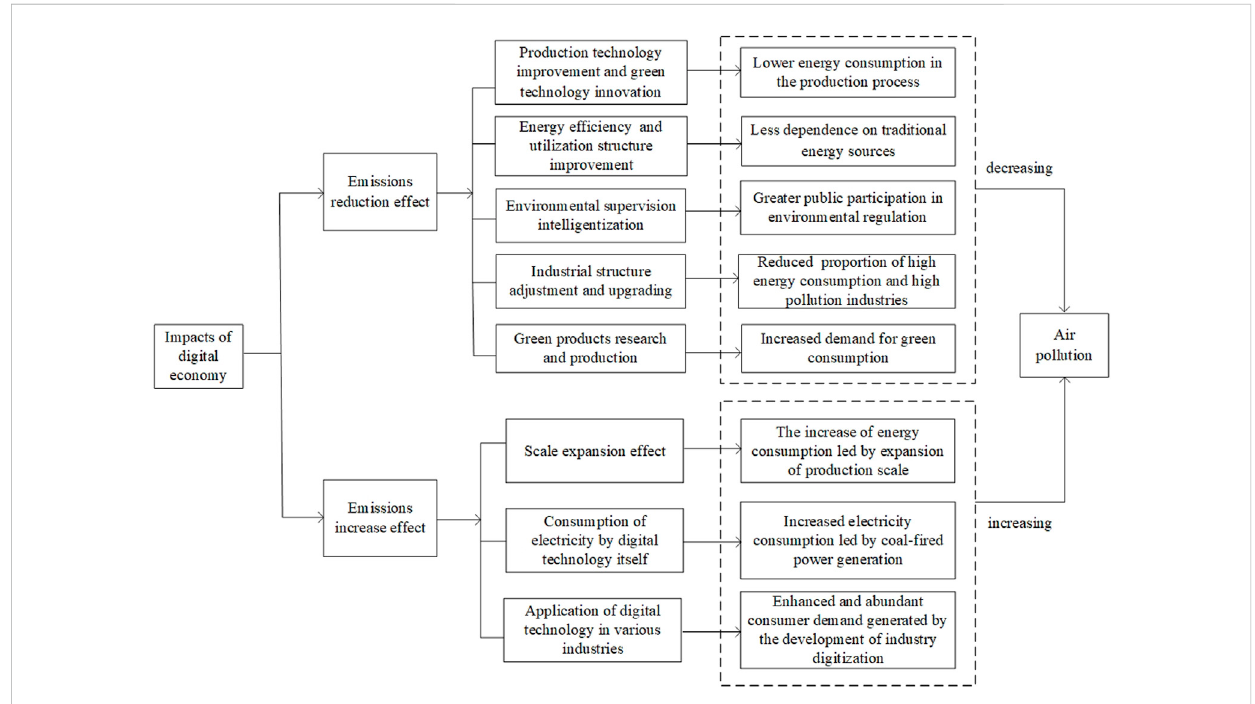
FIGURE 1 Mechanisms of bilateral effects of the digital economy on air